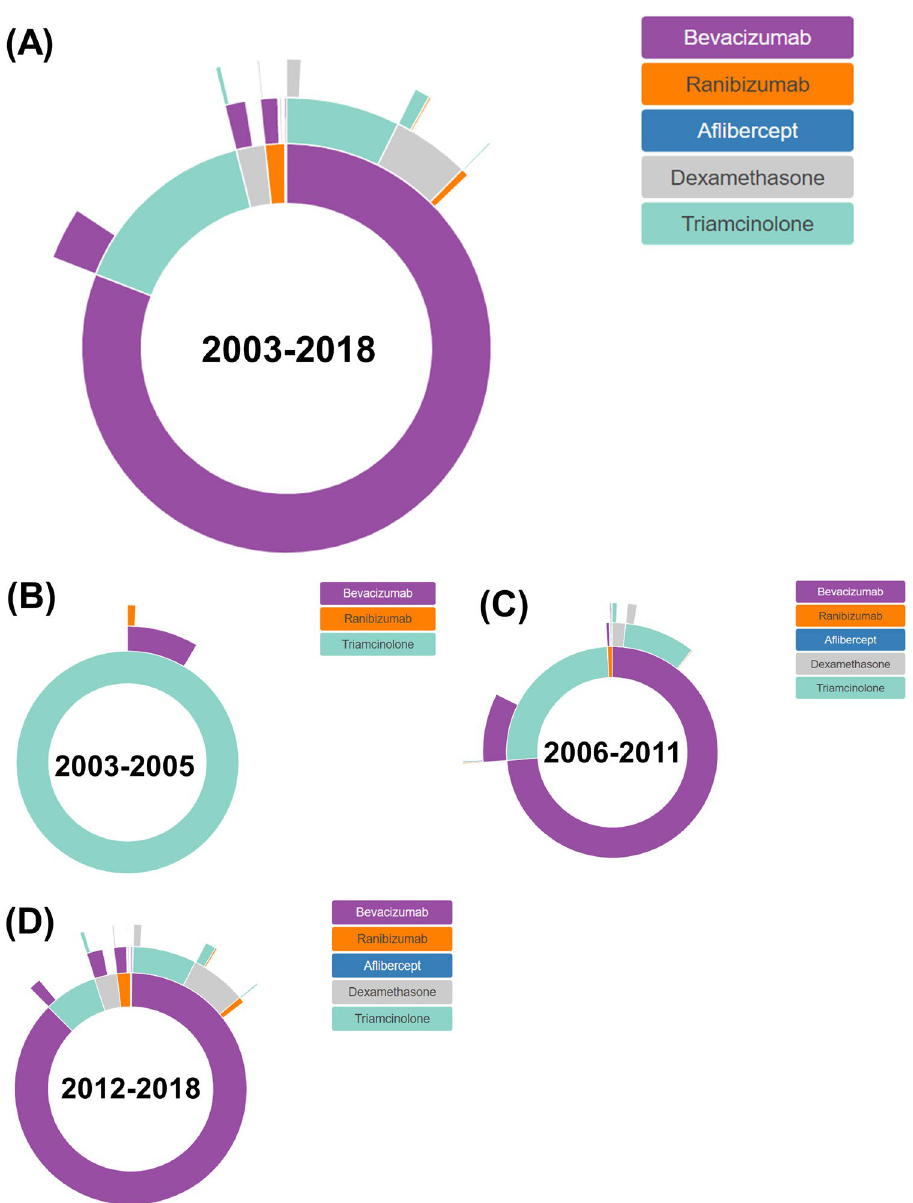
Figure 3. Sunburst diagrams of treatment pathways for macular edema following retinal vein occlusion. ( A ) Entire period, ( B ) January 2003–December 2005, ( C ) January 2006–December 2011, ( D ) January 2012– December 2018. R (version 3.6.3, https:// cran.r- proje ct. org) and sunburstR package (version 2.1.6, https:// cran.r- proje ct. org/ web/ packa ges/ sunbu rstR/ index. html) are used to generate this